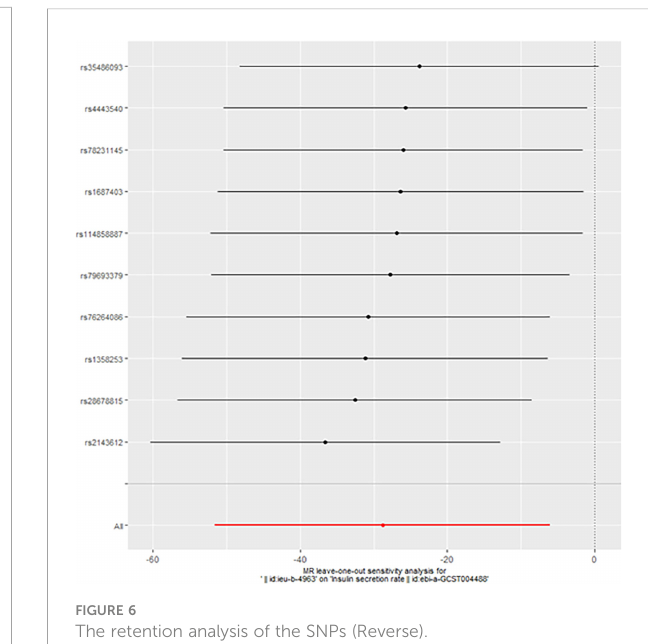
FIGURE 6 The retention analysis of the SNPs